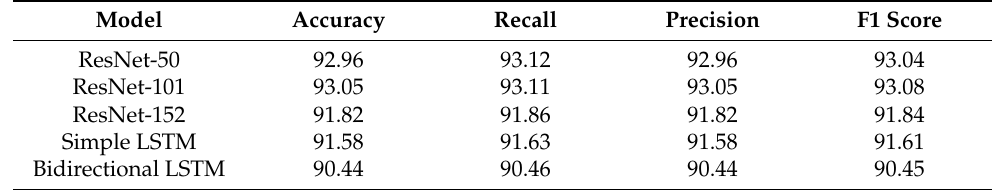
Table 2. Performance of age group classification in the targeted box and block test (Experiment 1).